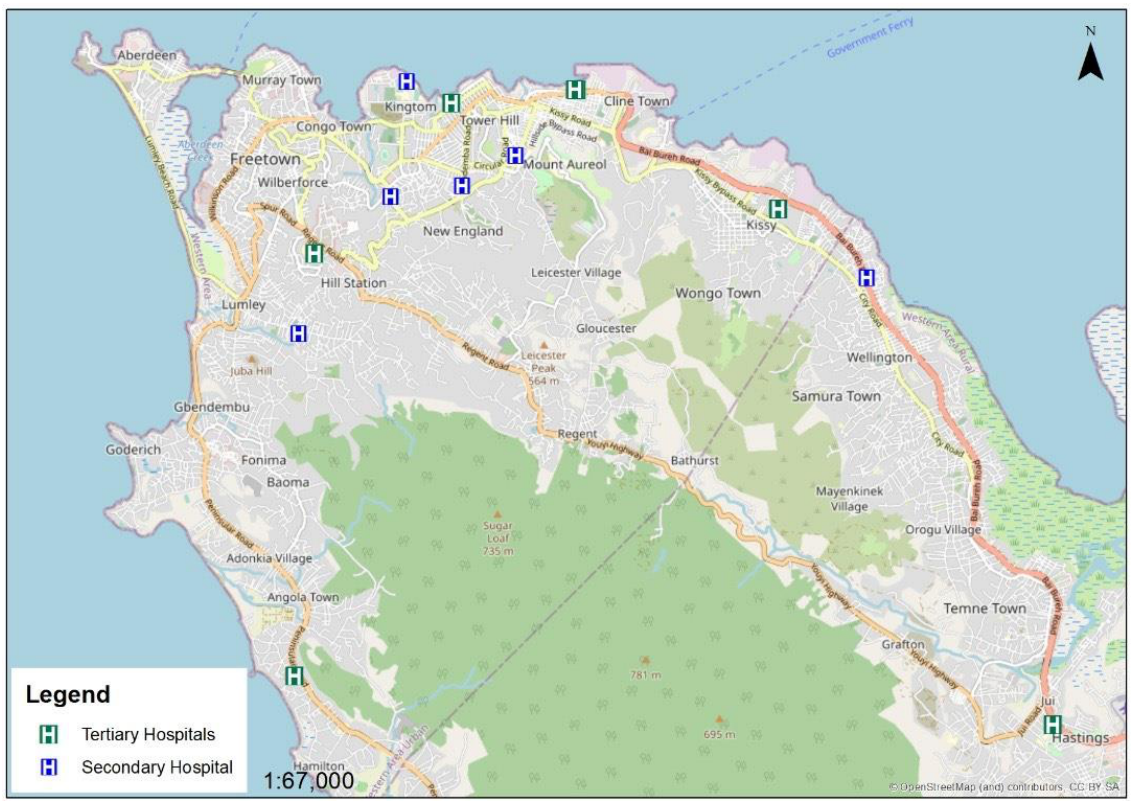
Figure 1. Map of Freetown showing the 13 public hospitals in the Western Area of Sierra Leone.